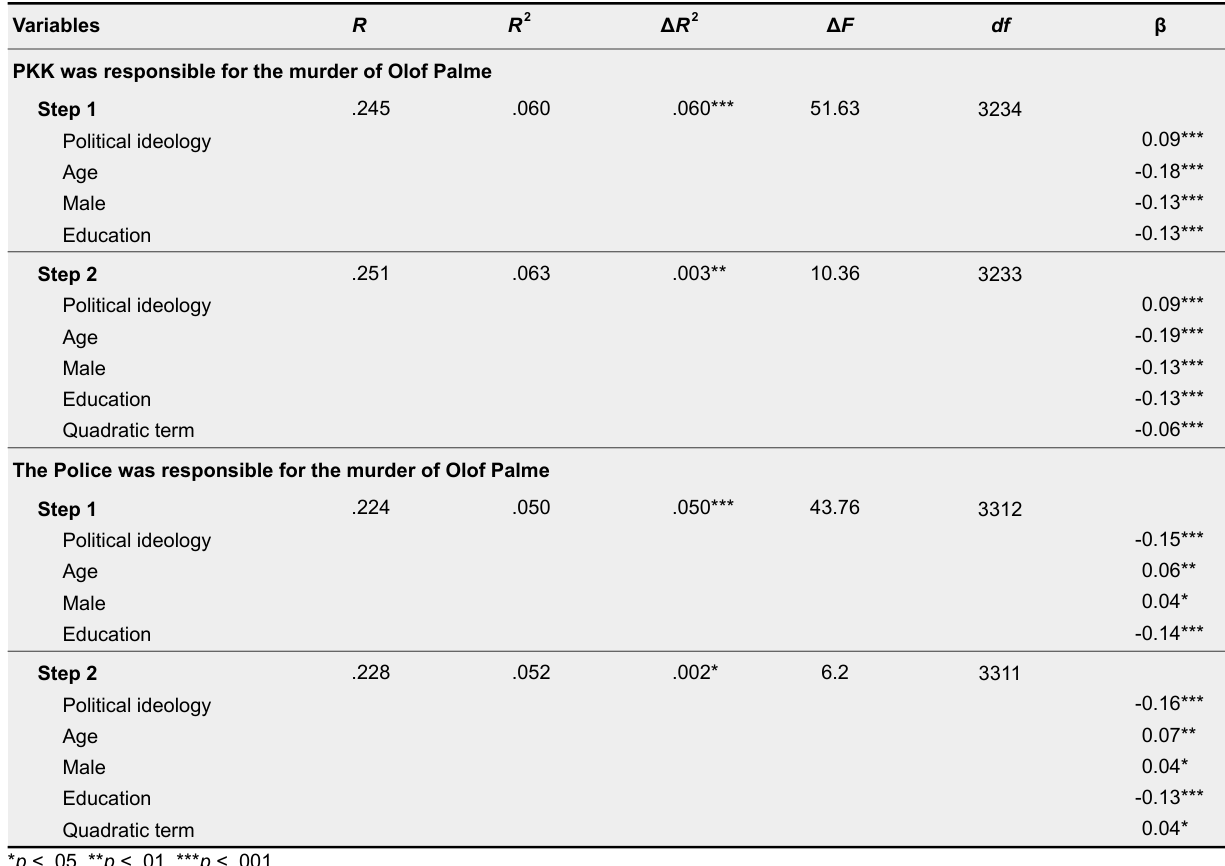
Determinants Explaining Conspiracy Belief Regarding the Murder of Olof